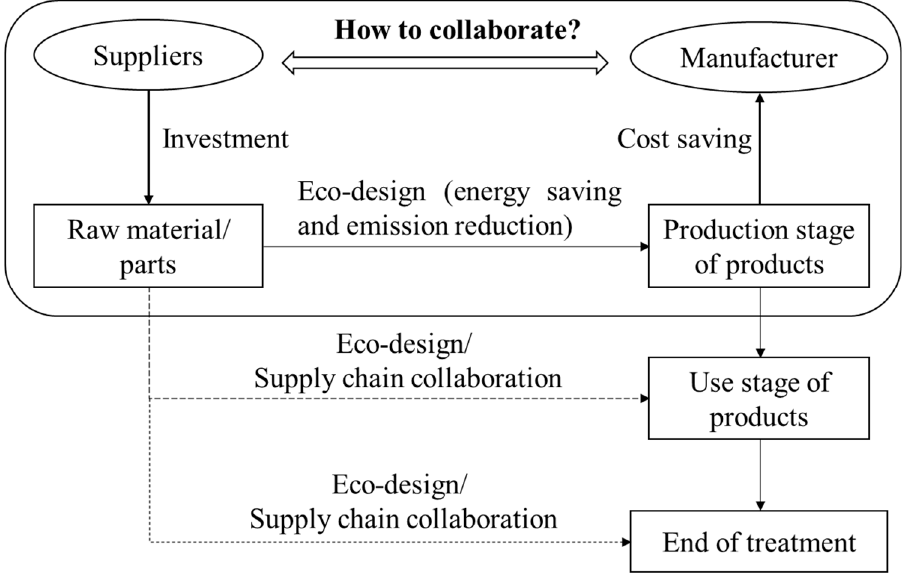
Figure 1. Eco-design models for the reduction of energy consumption and pollutant emission in the downstream production process. downstream production